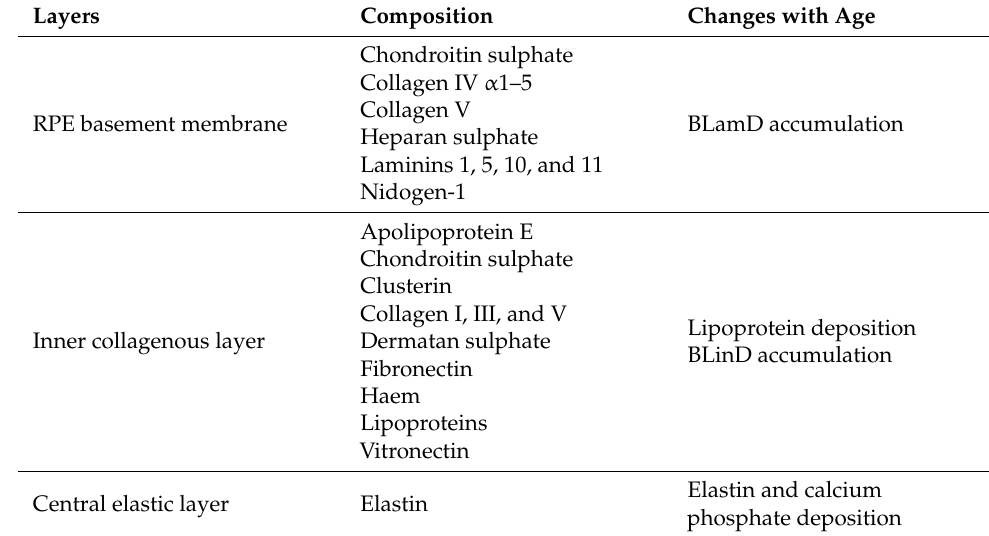
Table 2. Changes in the composition of each layer of BrM with